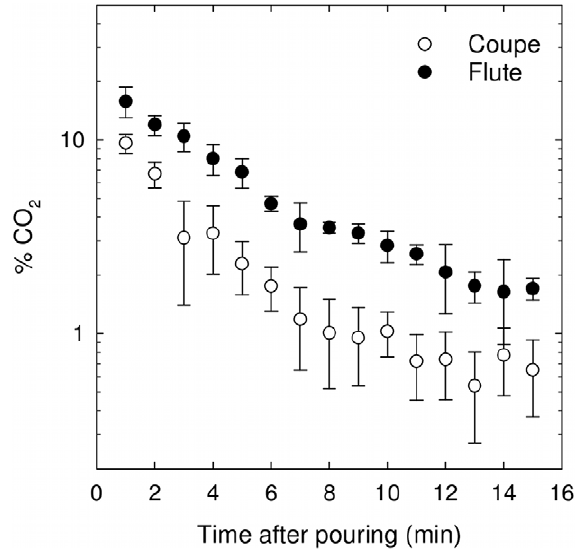
Figure 4. Monitoring gaseous CO 2 concentrations in the headspace of a flute or a coupe filled with champagne. CO 2 concentrations found in the headspace, all along the first 15 min after pouring champagne (for a bottle stored at 20 u C), depending on whether champagne is served into the flute or into the coupe; each datum of each time series is the arithmetic average of six successive values recorded from six successive pouring; standard deviations correspond to the root-mean-square deviations of the values provided by the six successive data recordings.